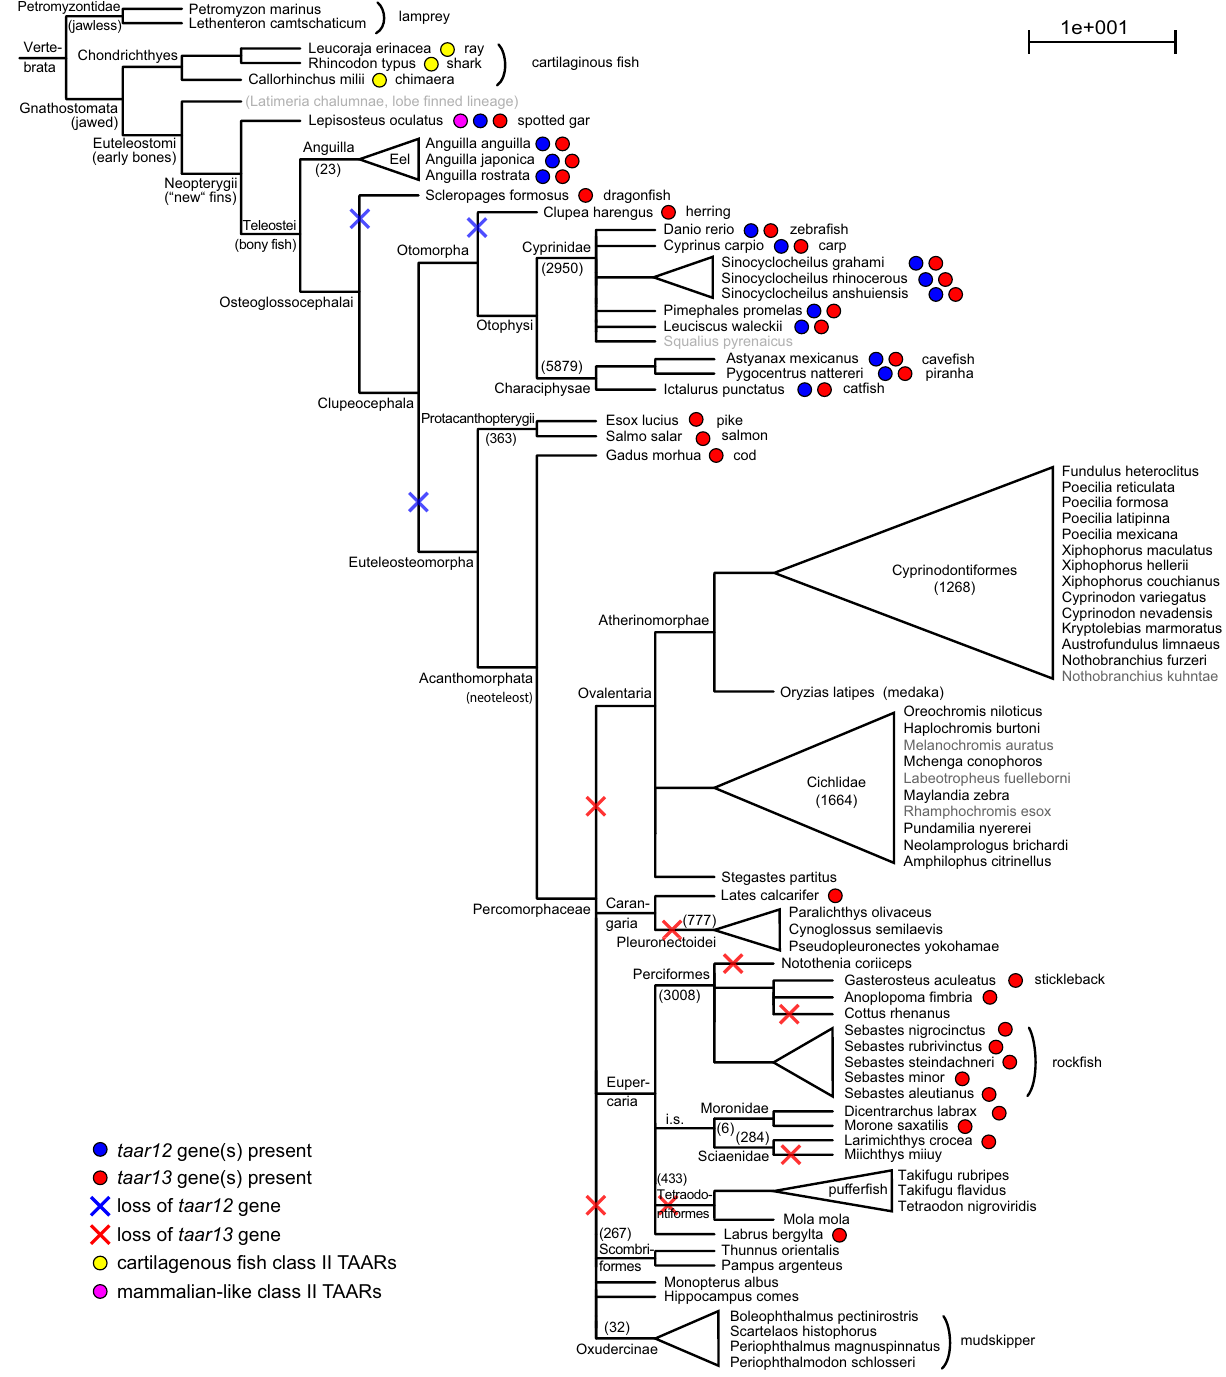
Figure 8. Gene gains and losses visualized in species tree. Phylogenetic species tree including all species whose genomes were analysed. Latin names are shown, for vernacular names see Table 1. Reference species and species with incomplete genome are shown in grey. The tree was drawn based on the phylogenetic relationships shown in 25 . Some higher order classifications are included for clarity, with the number of species in the respective clade given in parentheses 44 . Yellow dots, class II TAARs are present in the respective species; magenta dots, mammalian-like class II TAARs are present; red dots, taar13 genes are present; blue dots, taar12 genes are present. Crosses depict gene losses predicted according to maximum